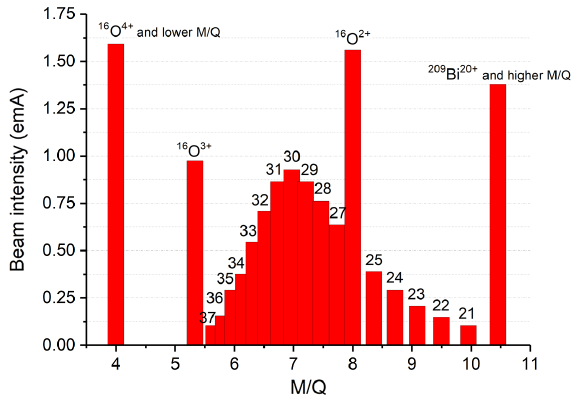
FIG. 12. CSD for bismuth and oxygen (supporting gas) ions.